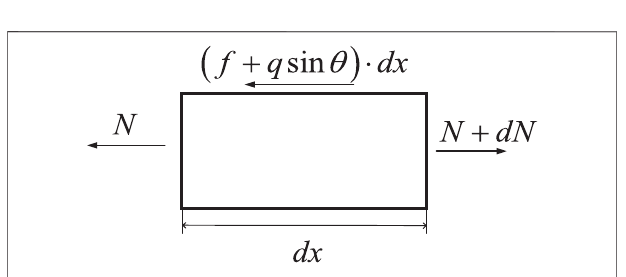
FIGURE 6 | A schematic diagram of the total axial force in the pipeline